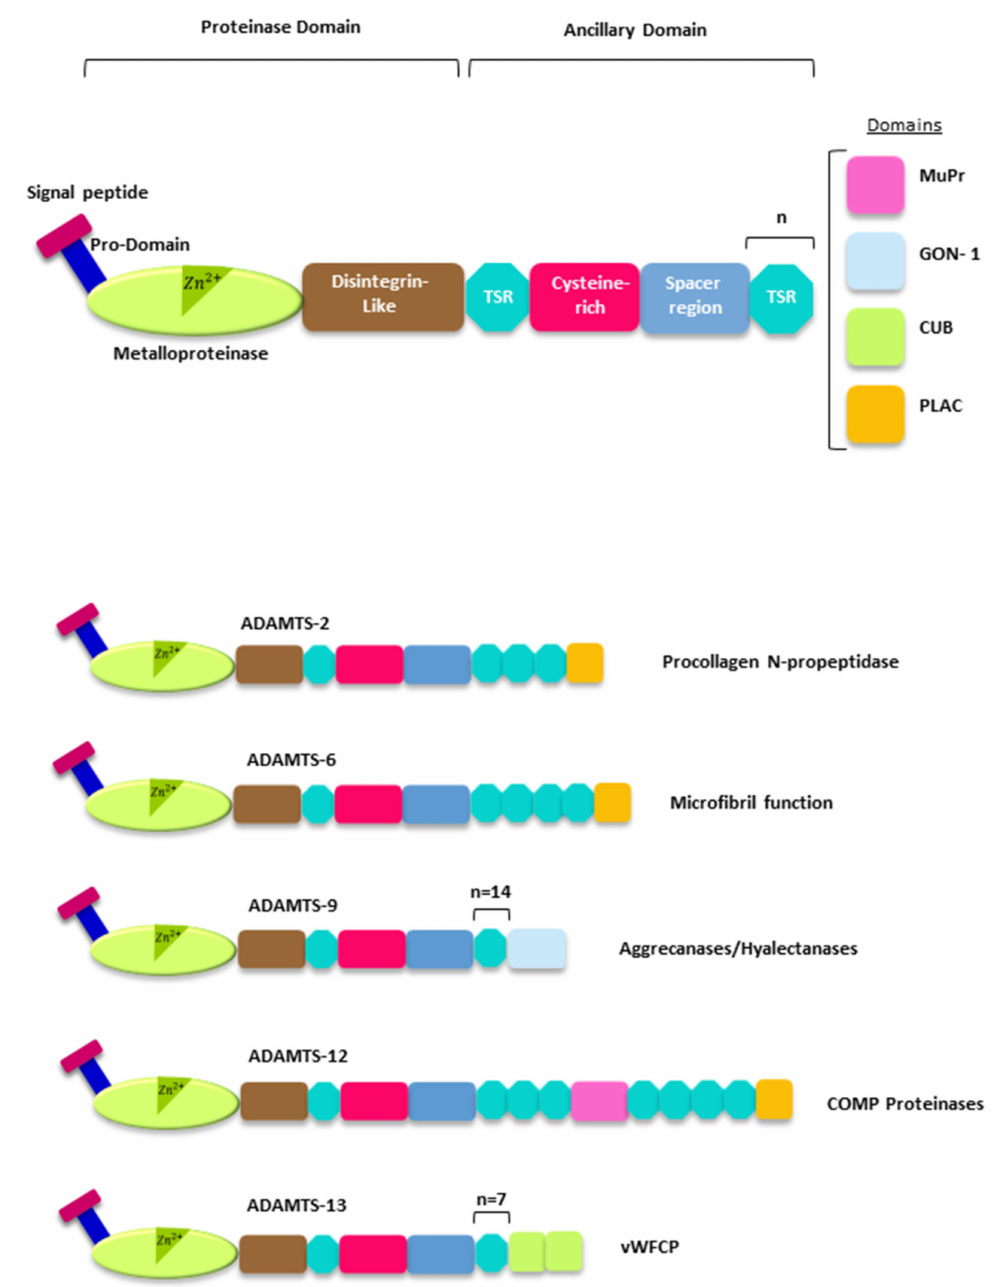
Figure 2. The ADAMTS family of metalloproteases. Top, schematic representation of the structure of the ADAMTS metalloproteases. TSR, thrombospondin type I motif. MuPr, mucin/proteoglycan domain. GON-1, CUB and PLAC domains (“ n ”, number of repetitions of the indicated domain). Bottom, representative members of the ADAMTS family from each of the functional subgroups: procollagen N -propeptidase, aggrecanases/hyalectanases, COMP proteinases, vWFCP and ADAMTSs (A Disintegrin and Metalloprotease domains, with thrombospondin motifs) related to microfibril function. For detailed information about the molecular architecture of the ADAMTS metalloproteases see reference